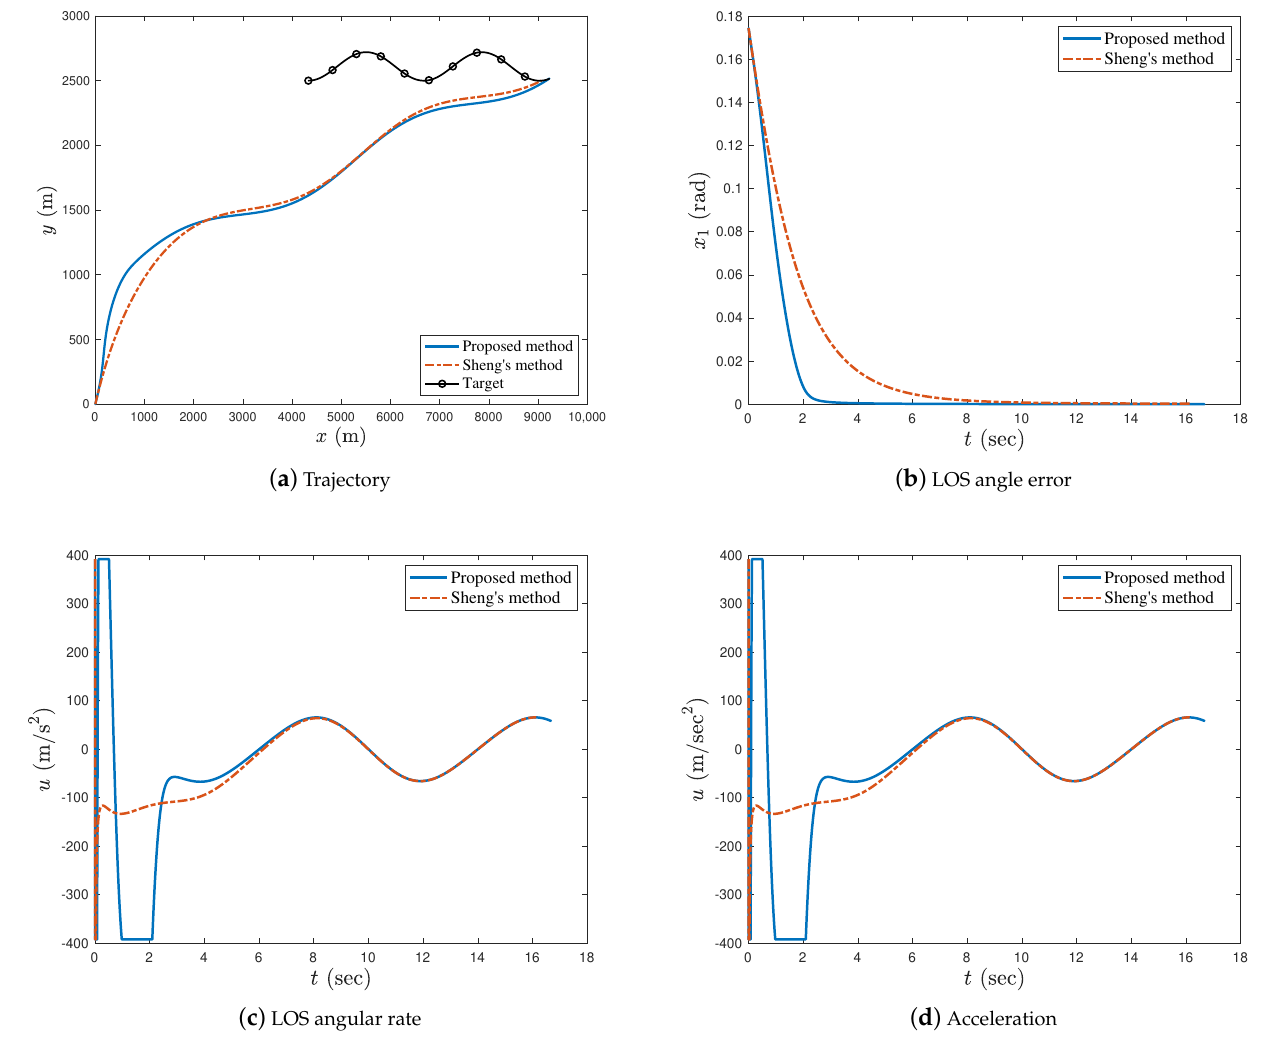
Figure 12. Comparison of the proposed method and the method in Ref. [15] with α = 0.07. When α = 0.07, the proposed fractional-order guidance law and the fractional-order guidance law from Ref. [15] successfully intercepted a target (see Figure 12a). The conver- gence speed of the LOS angle error and LOS angular rate with the proposed guidance law were faster than those with the guidance law from Ref. [15]. As shown in Figure 12d, the accelerations of the missiles with the proposed guidance law and guidance law in Ref. [15] were all within a reasonable scope, but there was acceleration saturation when using the proposed method to achieve faster